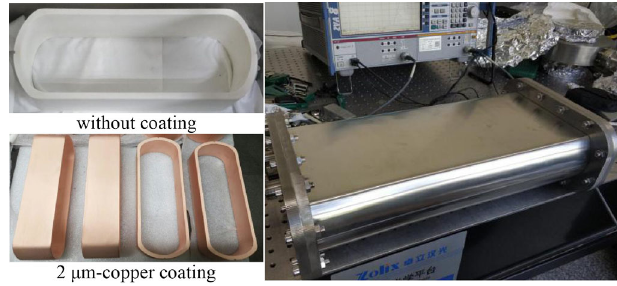
FIG. 15. Impedance measurement platform.